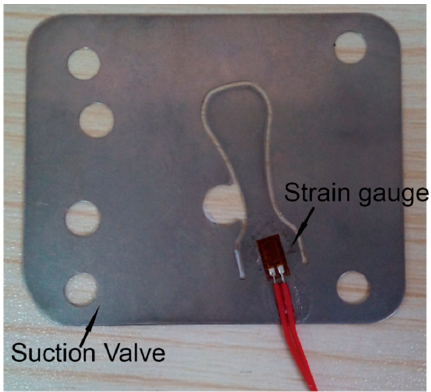
Figure 9. Schematic of the strain gauge installation.